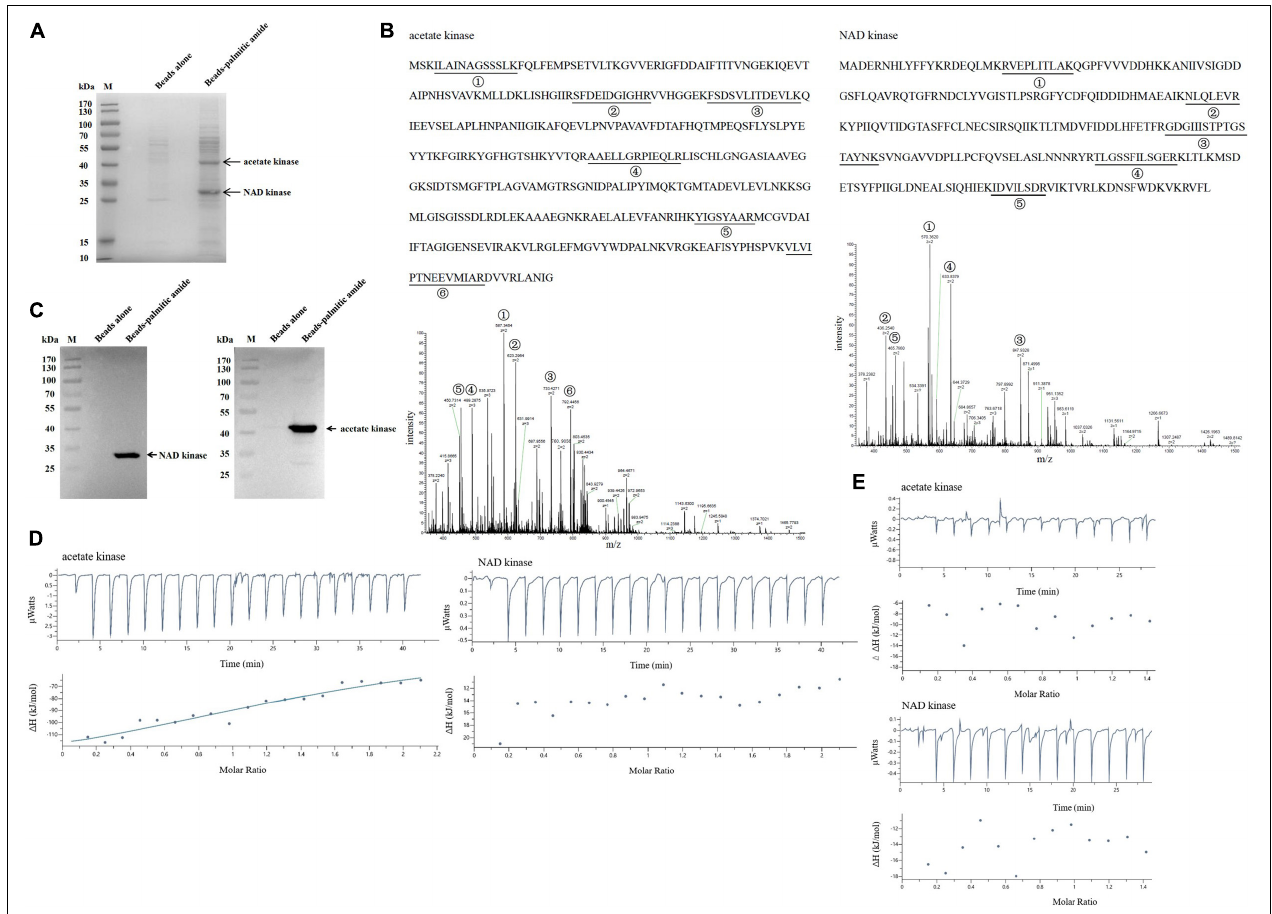
FIGURE 4 | The proteins interacted with palmitic amide. (A) The proteins bound to palmitic amide. Geobacillus sp. E263 was lysed by ultrasonication and the proteins in supernatant were incubated with palmitic amide-coupled NHS-activated beads. The proteins were separated by SDS-PAGE with Coomassie brilliant blue staining. NHS- activated beads alone was used as a control. The arrows represented the differential proteins. M, protein marker. (B) Identification of the proteins bound to palmitic amide by mass spectrometry. The proteins were identified to be acetate kinase and nicotinamideadenine dinucleotide (NAD) kinase, respectively. The matched peptides were indicated with underlines. (C) Western blot analysis of the proteins interacted with palmitic amide. The proteins extracted from Geobacillus sp. E263 were incubated with palmitic amide-coupled beads, and then subjected to Western blot using NAD kinase-specific or acetate kinase-specific antibody. The target protein was indicated with an arrow. M, protein marker. (D) Interaction between palmitic amide and acetate kinase or NAD kinase. The purified recombinant acetate kinase (20 µ M) or NAD kinase (20 µ M) was incubated with palmitic amide (200 µ M) to conduct isothermal titration calorimetry (ITC). (E) Evaluation of the binding of palmitic acid to acetate kinase or NAD kinase by ITC. Palmitic acid (200 µ M) was incubated with the purified recombinant acetate kinase (20 µ M) or NAD kinase (20 µ M) to perform